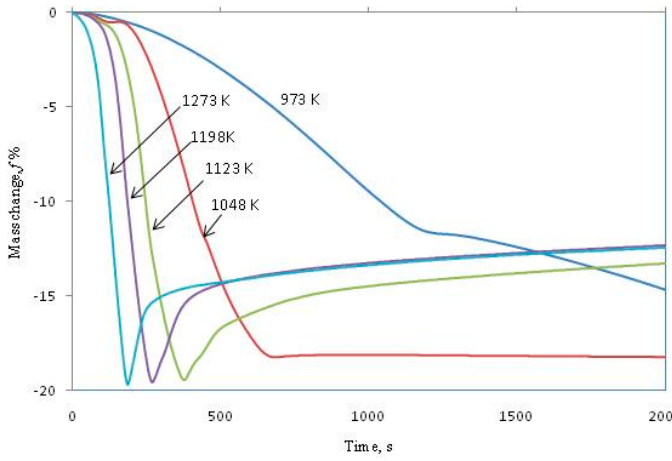
Figure 15. Mass change percentage of the oxide mixture 10.67 wt. pct NiO and 89.33 wt. pct WO 3 vs.